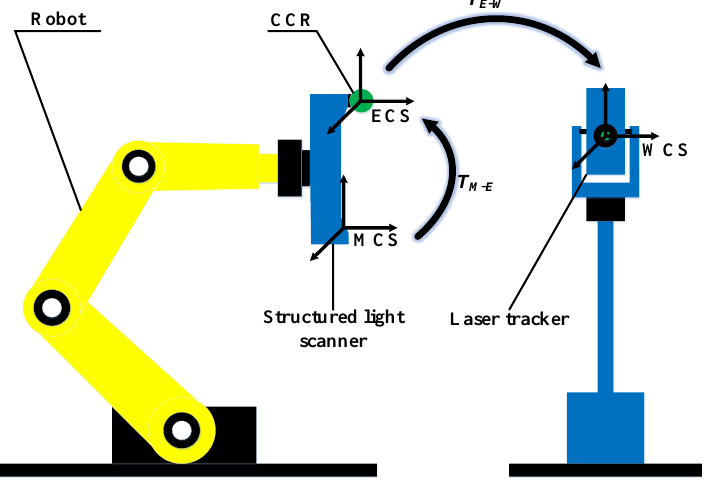
Figure 2. Definition of the coordinate system.